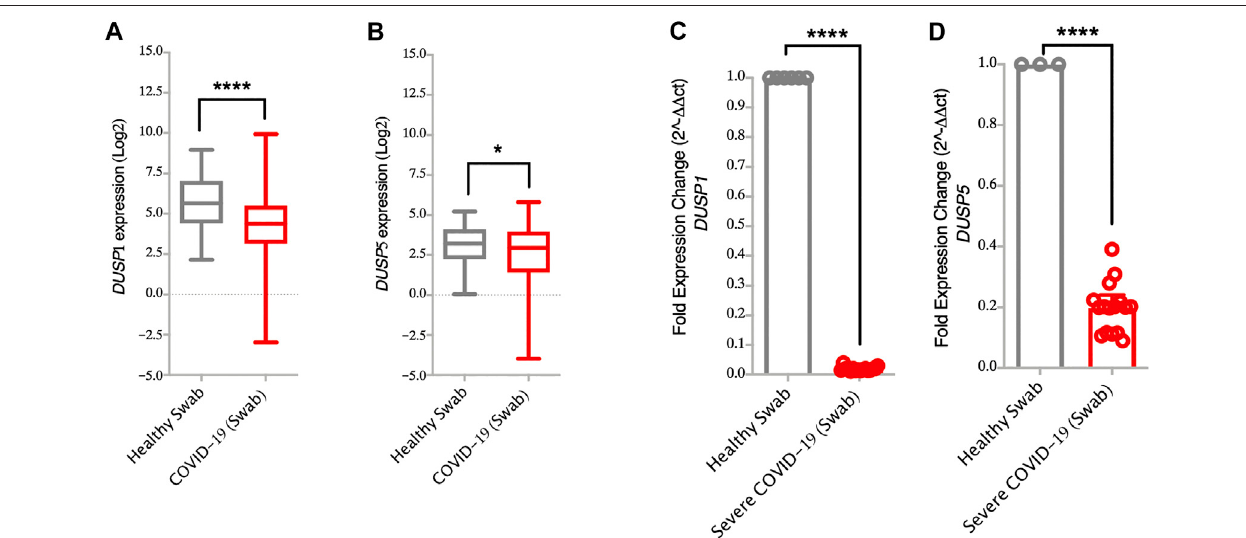
FIGURE 2 | Lower gene expression levels of DUSP1 and DUSP5 in nasopharyngeal swabs from COVID-19 patients compared to healthy controls (A,B) Gene expression level of DUSP1 and DUSP5 in COVID-19 ( n (cid:1) 430) and in healthy ( n (cid:1) 54) nasopharyngeal swabs (Dataset GSE152075). Expression level of DUSP1 and DUSP5 is signi fi cantly lower in nasopharyngeal swabs from COVID-19 patients as compared to healthy controls (C,D) Con fi rmation of gene expression level of DUSP1 and DUSP5 as measured by RT-PCR, in nasopharyngeal swabs of severe COVID-19 patients (n (cid:1) 16) and healthy controls (n (cid:1) 6). Expression level of DUSP1 and DUSP5 is lower in nasopharyngeal swabs from COVID-19 patients as compared to healthy controls. Two-way comparison was done using t -test or Mann-Whitney U test, depending on the skewness of the data. * p < 0.05, **** p < 0.0001.